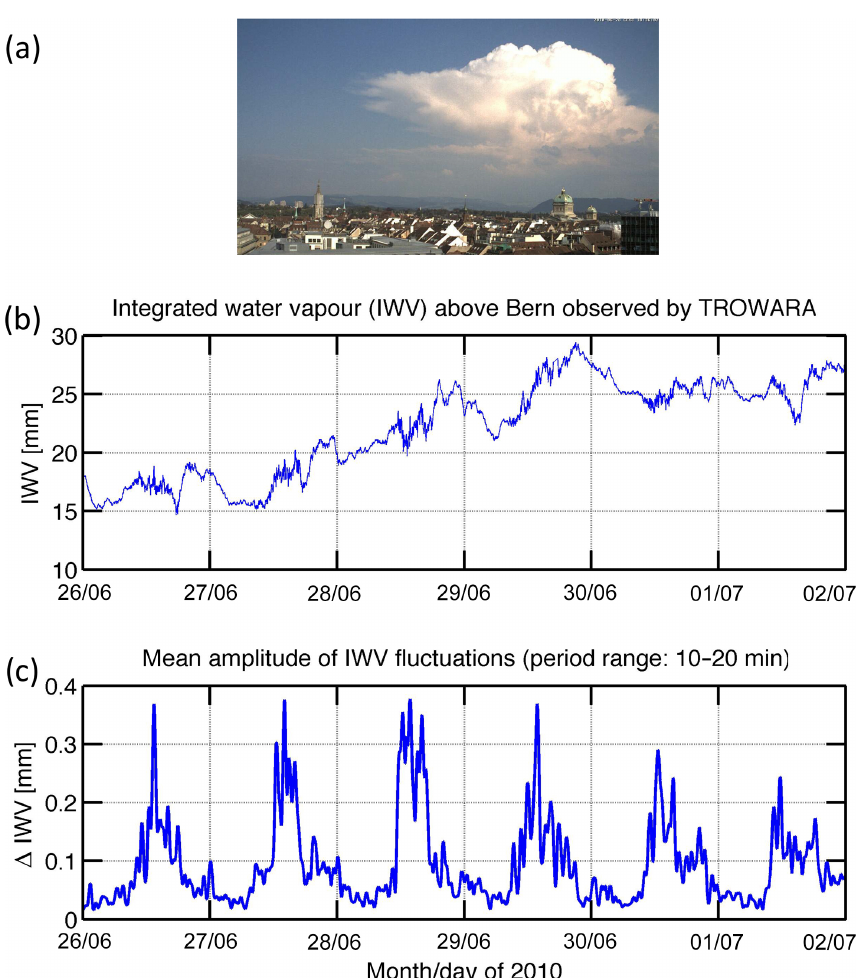
Figure 1. (a) The convection cell built up within 45min to the south of Bern on 28 June 2010 (the picture was taken at 16:36UT). (b) Inte- grated water vapour (IWV) as a function of time (month/day) observed by the Tropospheric Water Radiometer (TROWARA) at Bern. IWV fluctuations regularly occurred between 10:00 and 18:00UT. (c) Mean amplitudes of the bandpass filtered IWV fluctuations (period range 10 to 20min) show a strong diurnal variation. Day ticks are at